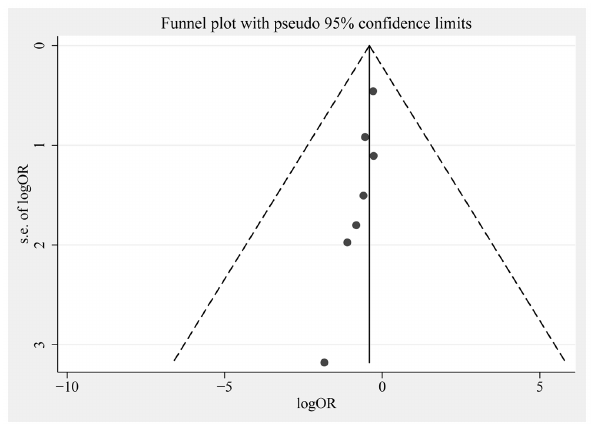
Figure 3. Funnel plot for the risk of ALI/ARDS in critically ill adult patients with pre-existing diabetes.or, risk ratio. s.e., standard error.